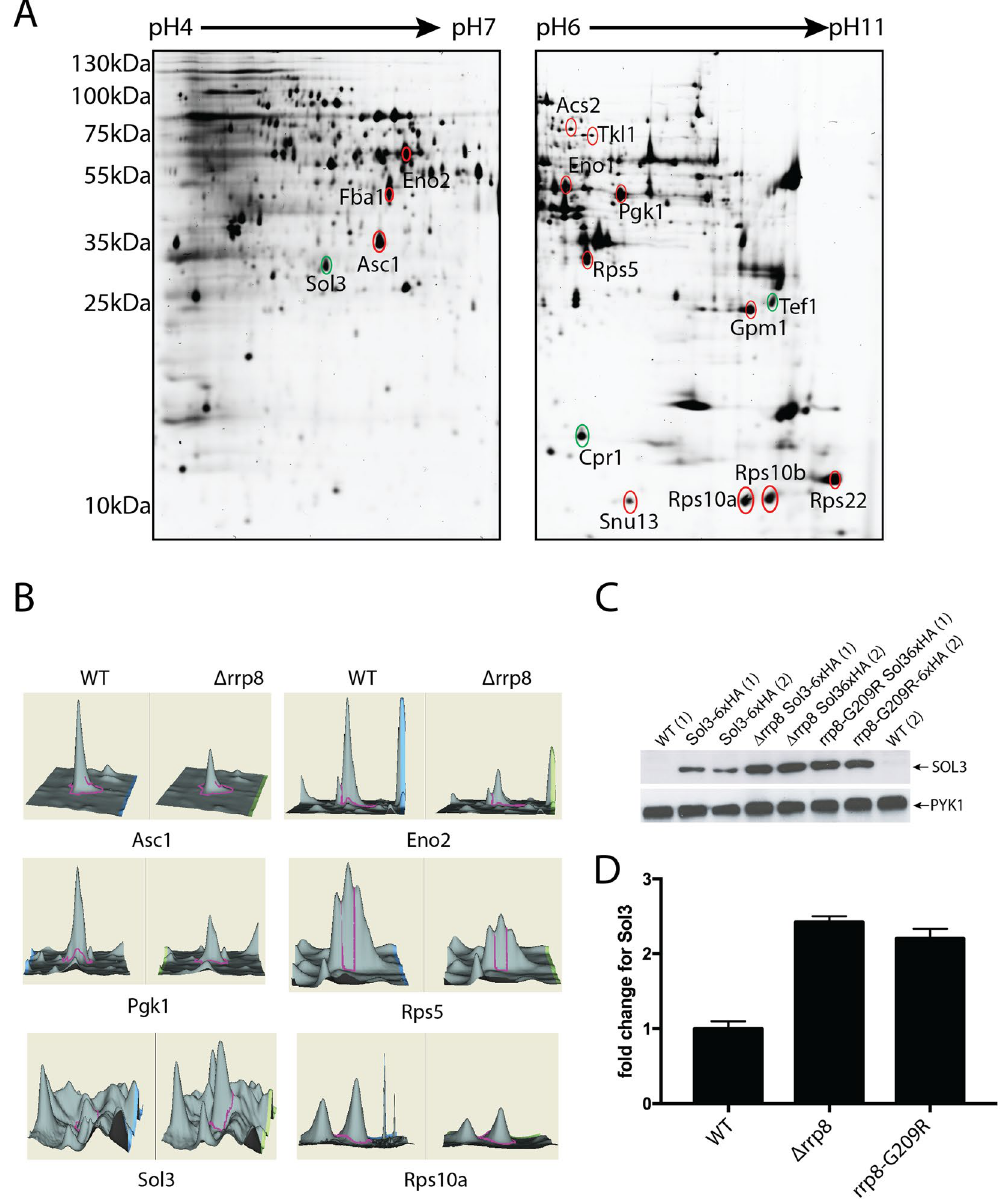
Figure 6. 2D proteome analysis of rrp8 mutant. ( A ) Scanned images of a typical 2-D DIGE gel of 50 µ g protein from the Cy3 labeled protein pool used for the rrp8 mutant strain (left gel: pH 4–7, right gel: pH 6–11). Differentially expressed proteins are annotated and were identified using ESI-MS/MS. Differentially expressed protein spots are annotated in red (down-regulated) or green (up-regulated). ( B ) DeCyder output showing the representative differentially expressed protein spots of Asc1, Eno2, Pgk1, Rps5, Sol3 and Rps10A along with their 3-D fluorescence intensity profiles. ( C and D ) Sol3 up-regulation is related to loss of m 1 A 645 methylation. Western blot analysis using anti-HA antibodies to analyze the expression of 6xHA tagged SOL3 in wild- type, Δ rrp8 and rrp8 G209R mutant cells. As loading control, PYK1 was detected with a specific antibody. The represented fold changes in SOL3 expression were quantified using ImageJ software